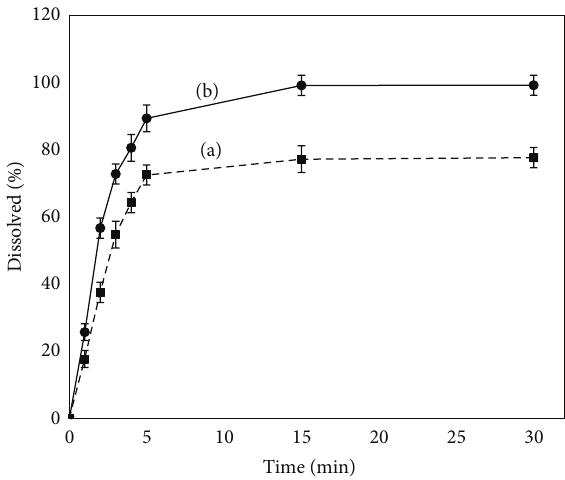
Figure 11: Solubility curves of r-Res (a) and u-Res (b) in vitro.